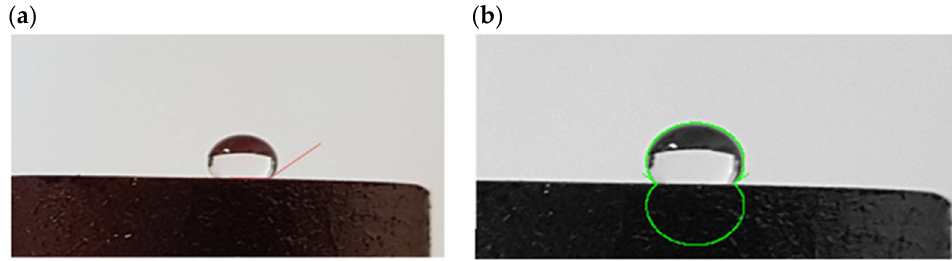
Figure 6. Determination of the static contact angle by means of drop shape analysis fitting with ( a ) the tangent and ( b ) ellipse method using the ImageJ software (LB-ADSA plugin).